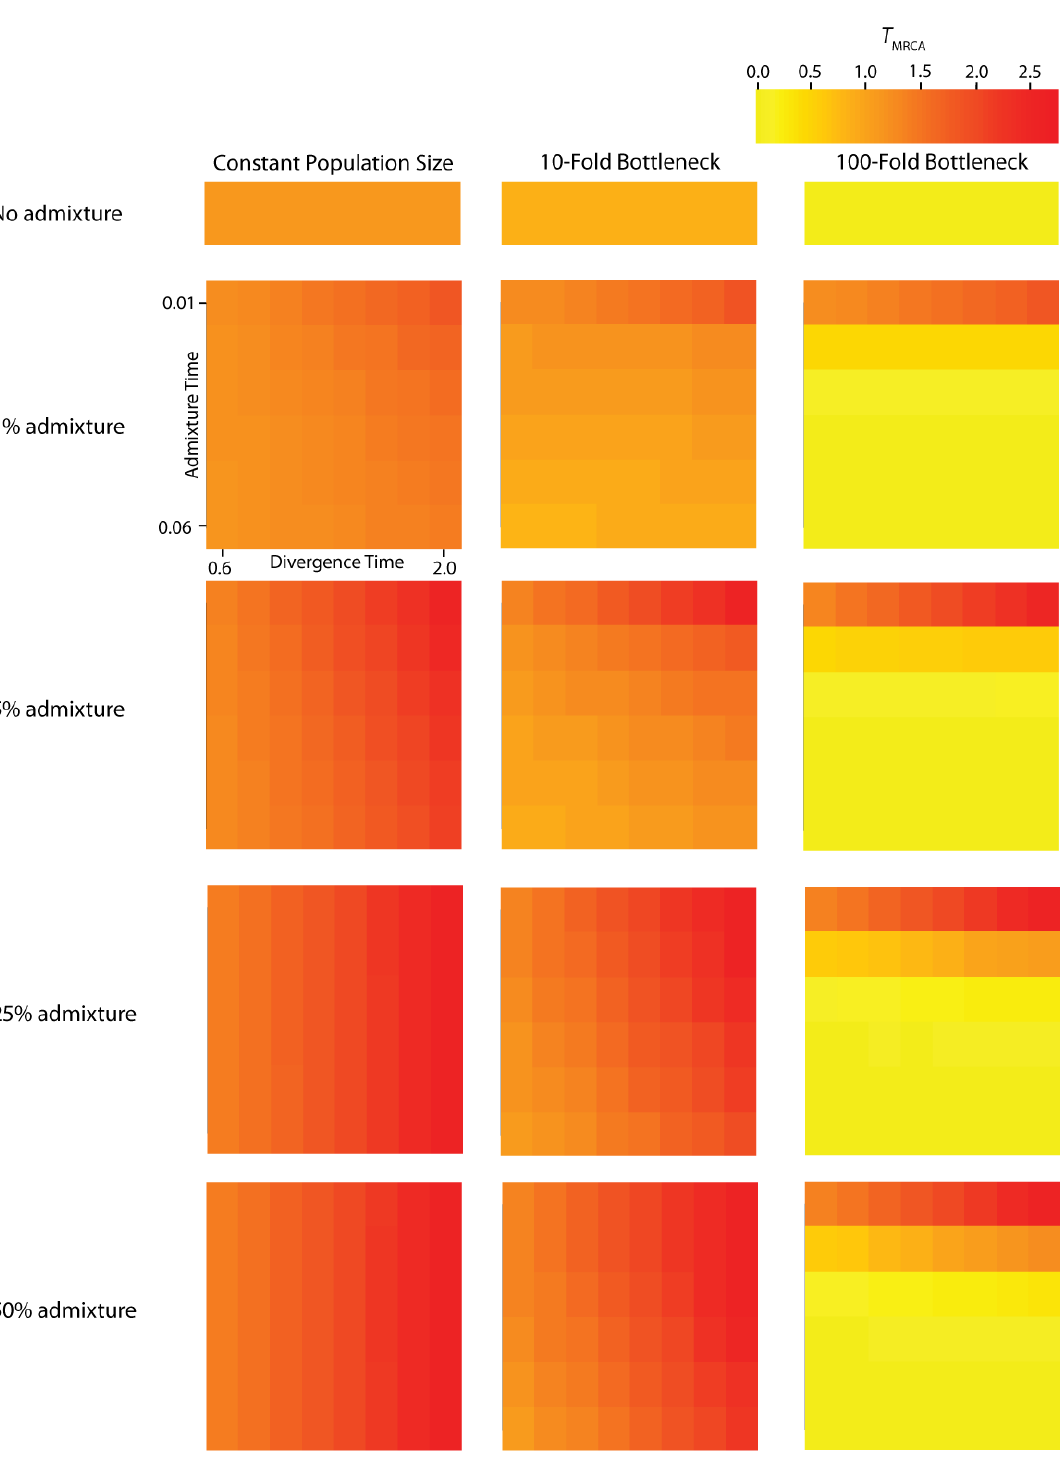
. Each column MRCA